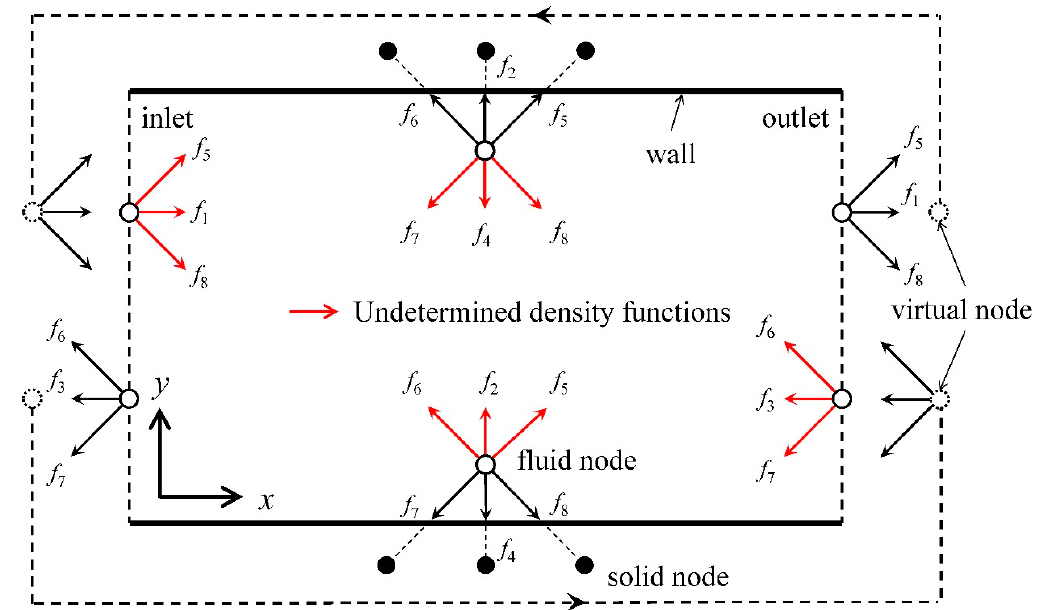
Figure 2. Schematic of the bounce-back rules and periodic boundary conditions for D2Q9 model. Periodic boundary conditions are also straightforward to impose in the LBM. As shown in Figure 2, distribution functions propagating out of the domain stream into the corresponding boundary node at the opposite boundary in the same direction. Take Figure 2 as an example, the inlet and outlet planes are periodic. As a result, the distribution functions f 1 , f 5 and f 8 at the outlet boundary will stream into the corresponding node at the inlet, while f 3 , f 6 and f 7 at the inlet propagate into the corresponding node at the outlet.